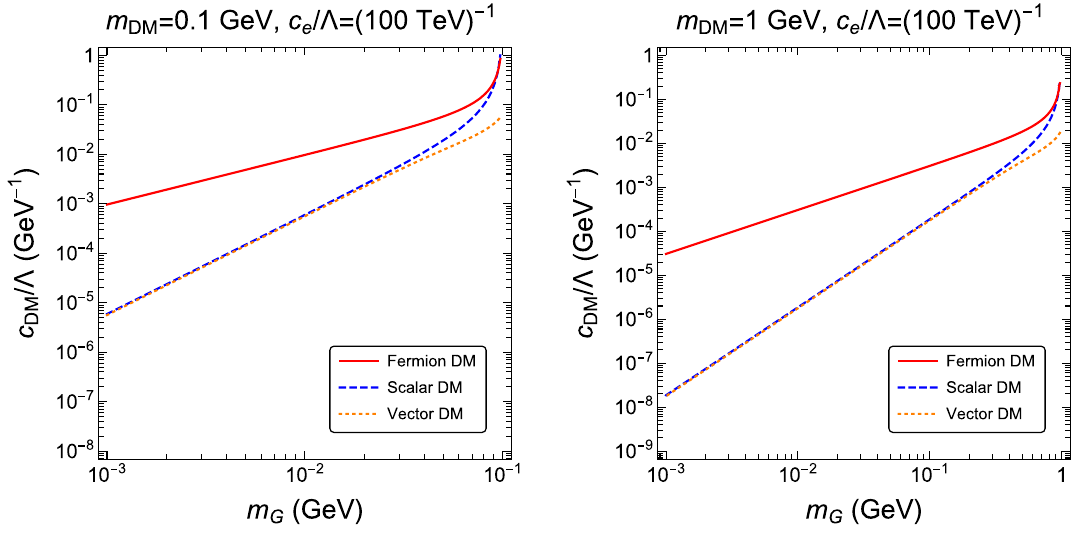
Fig. 4 Parameter space for c DM /(cid:3) vs m G for light dark matter with m DM > m G . The correct relic density is satisfied in red solid, blue dashed and orange dotted lines for fermion, scalar and vector dark mat-